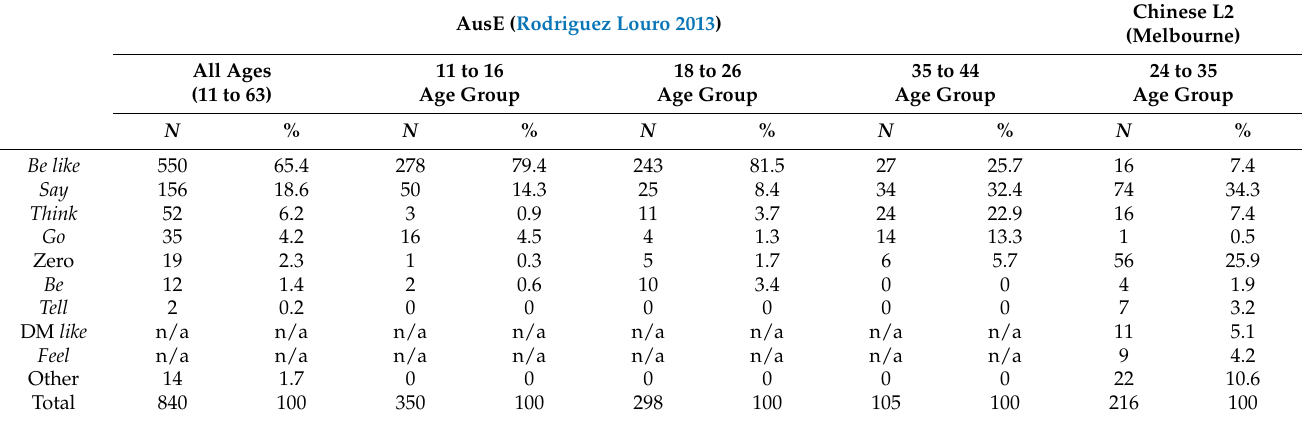
Table 5. Distribution of quotatives in the Chinese L2 corpus compared to Rodriguez Louro (2013). AusE (Rodriguez Louro 2013)